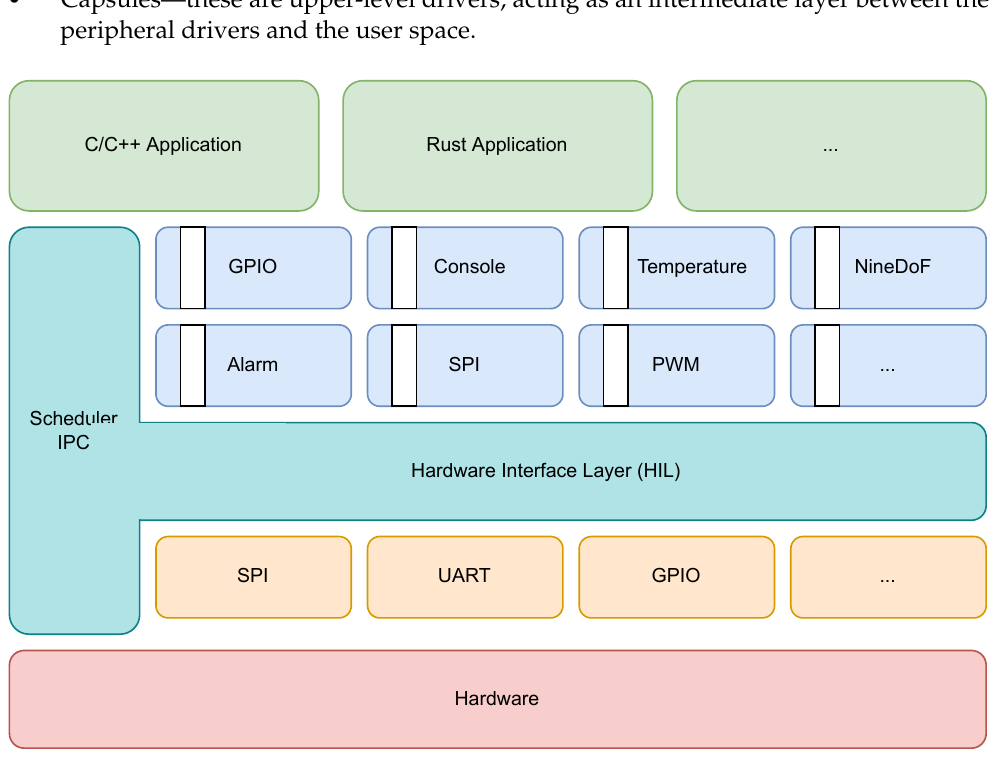
Figure 1. The Tock